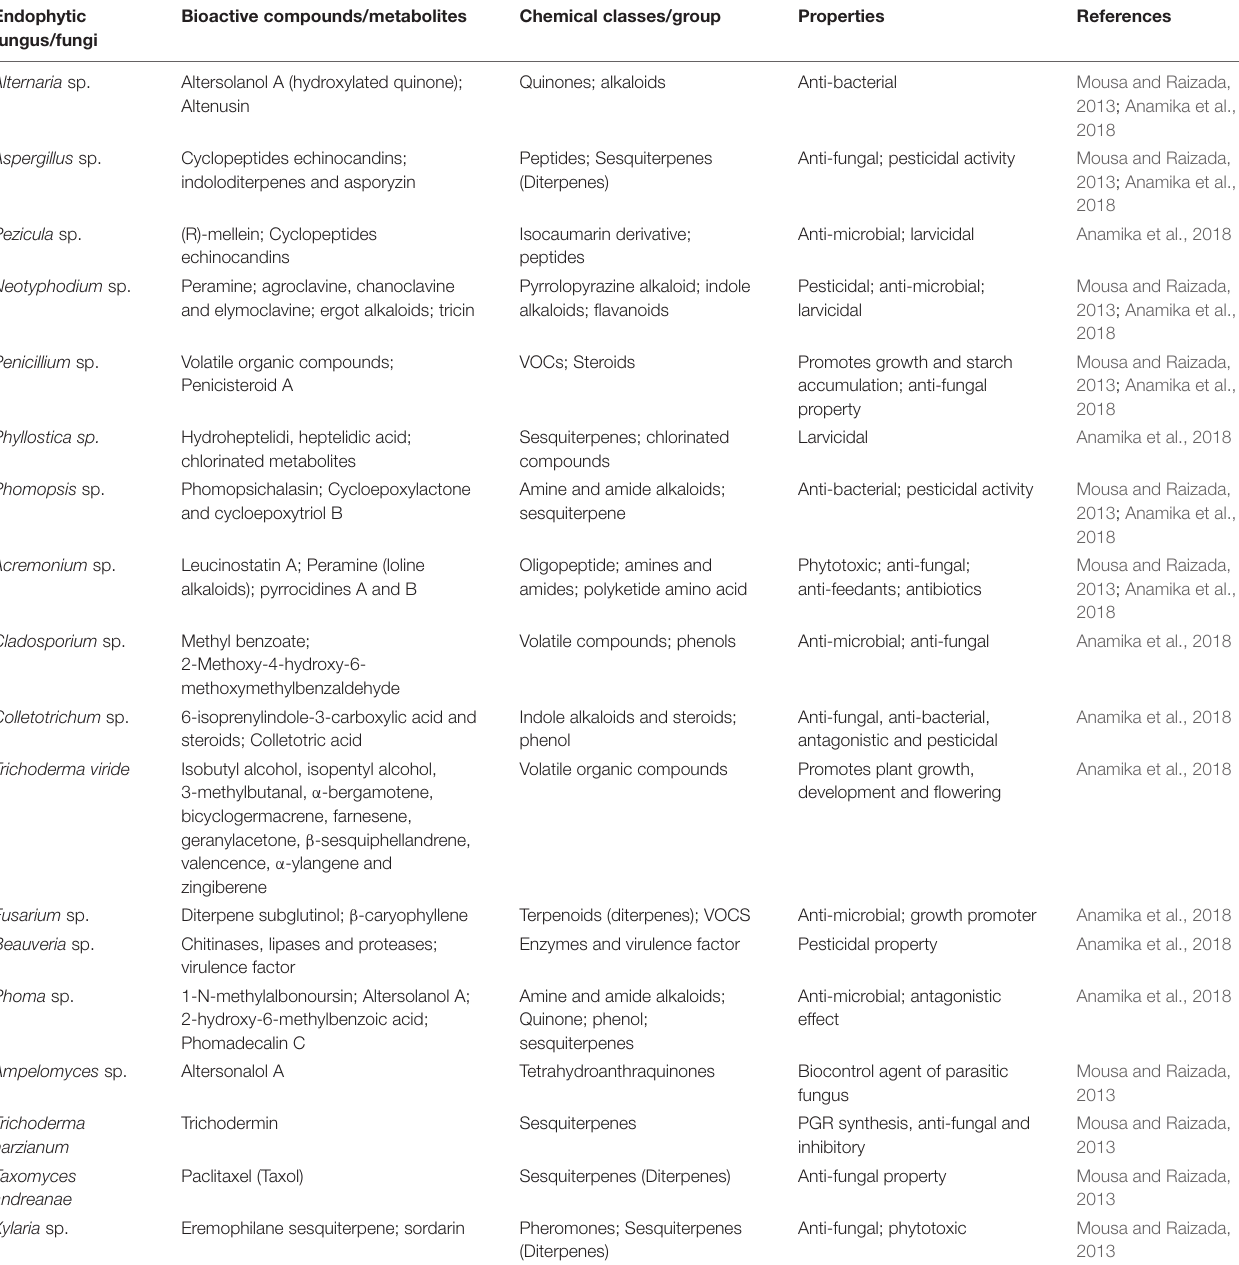
TABLE 2 | Endophytic fungi and their wide range of bioactive compounds with their